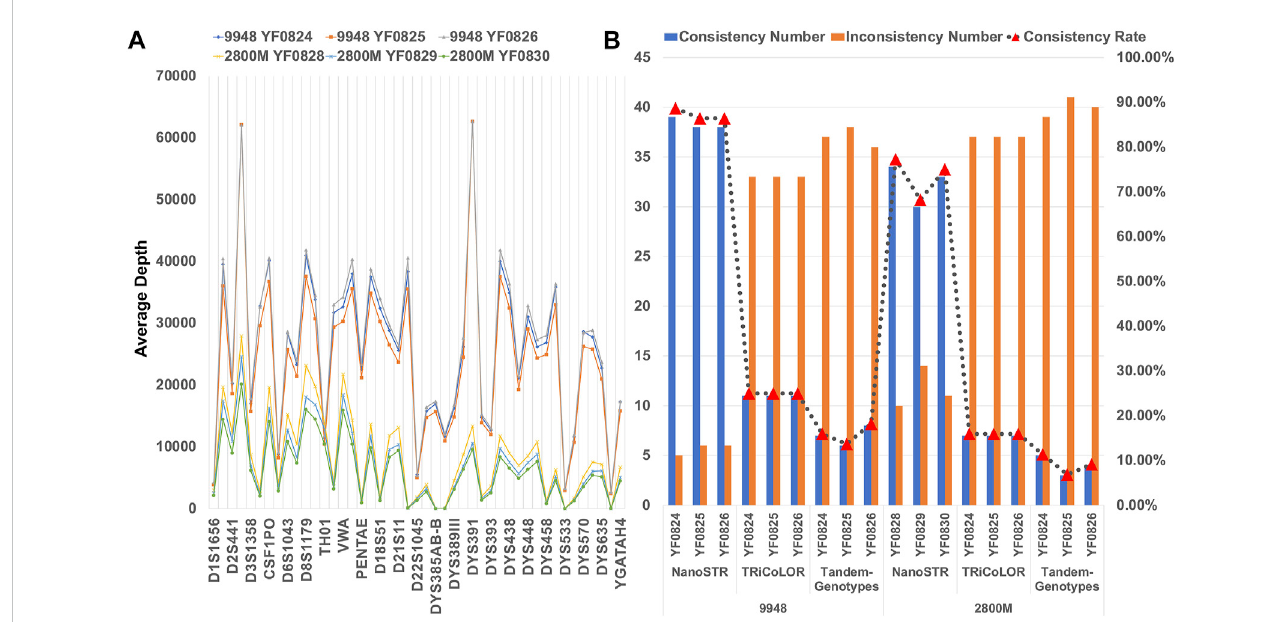
FIGURE 4 (A) Average depth of six standard samples at each STR locus with MinION sequencing platform; (B) performance of NanoSTR, TRiCoLOR, and Tandem- GenotypesonthestandardsampleswithMinIONsequencingplatform.Thebarsindicatethenumberofconsistent(blue)andinconsistent(orange)genotypes compared with the standard samples, and the triangle symbols connected by a dotted line represent the concordance